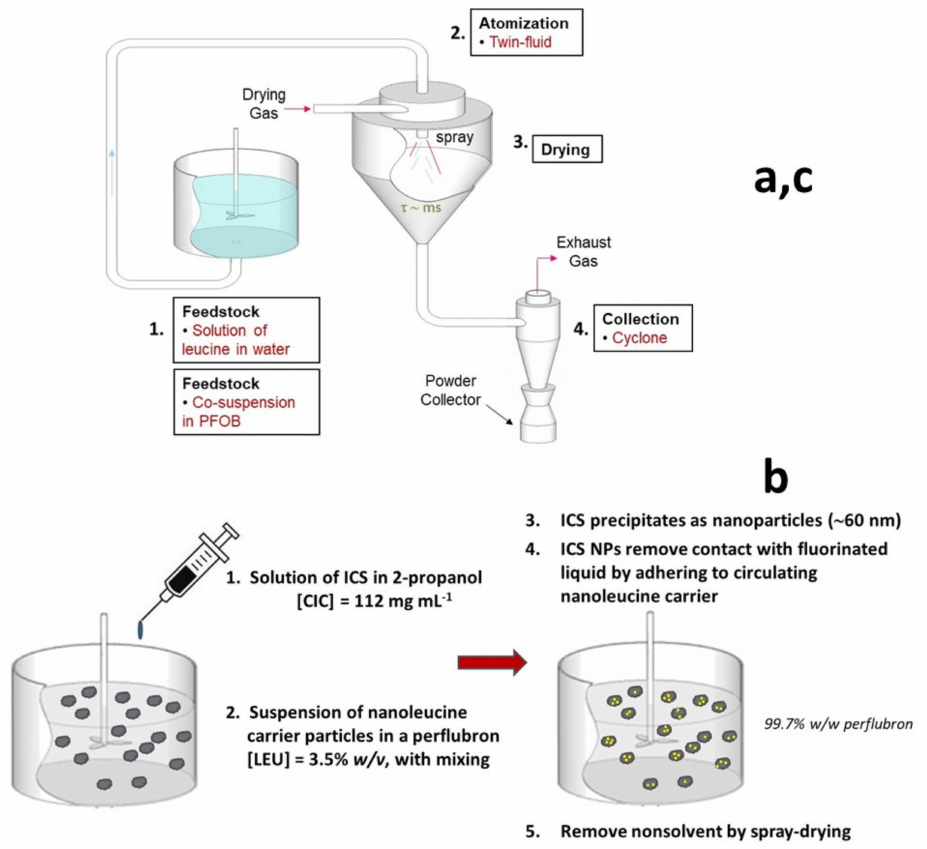
Figure 2. Process for the manufacture of adhesive mixtures of nanoleucine carrier particles and extrafine ciclesonide particles. ( a ) spray drying of leucine from a solution in water; ( b ) precipitation of nanoparticles of ciclesonide into a circulating dispersion of nanoleucine carrier particles in perflubron to form a co-suspension; ( c ) removal of perflubron to form a carrier-based dry powder comprising leucine nanoparticles adhered to nanoleucine